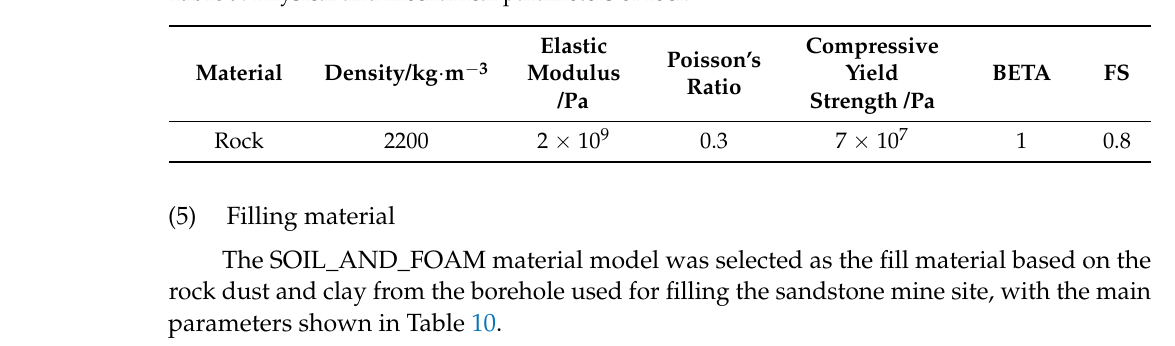
Table 9. Physical and mechanical parameters of rock.